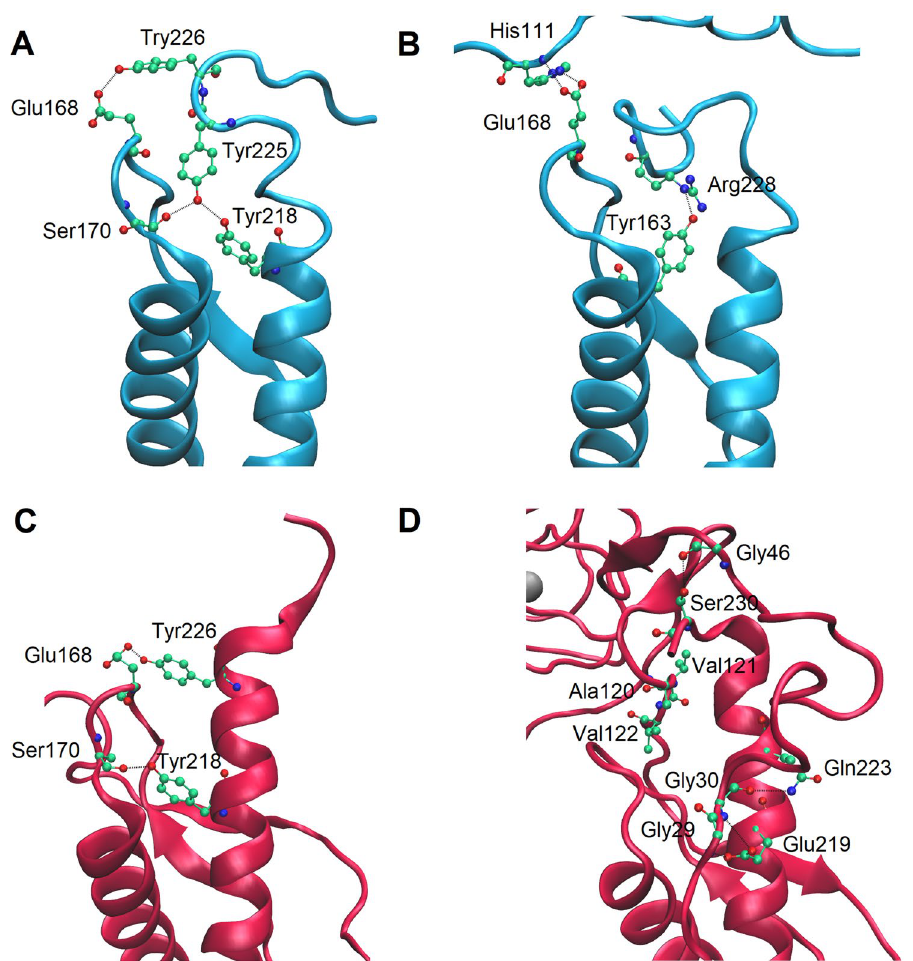
Figure 7. Different behavior of α-helix 3 in apo (blue) and holo (red) PrP C . The C-terminal region of α-helix 3 is stabilized by the β2-α2 loop (A,C) . In the apo form formation of a His111-Glu168 hydrogen bond results in rotation of Met166, which then affects the hydrogen bond formation between Arg228 and Tyr163, resulting in partial α-helix 3 unfolding (B) . In the holo form the hydrophobic amino acids Ala120, Val121, Val122 separate the β2-α2 loop from α-helix 3, and the N-terminal domain stabilizes α-helix 3 (D)